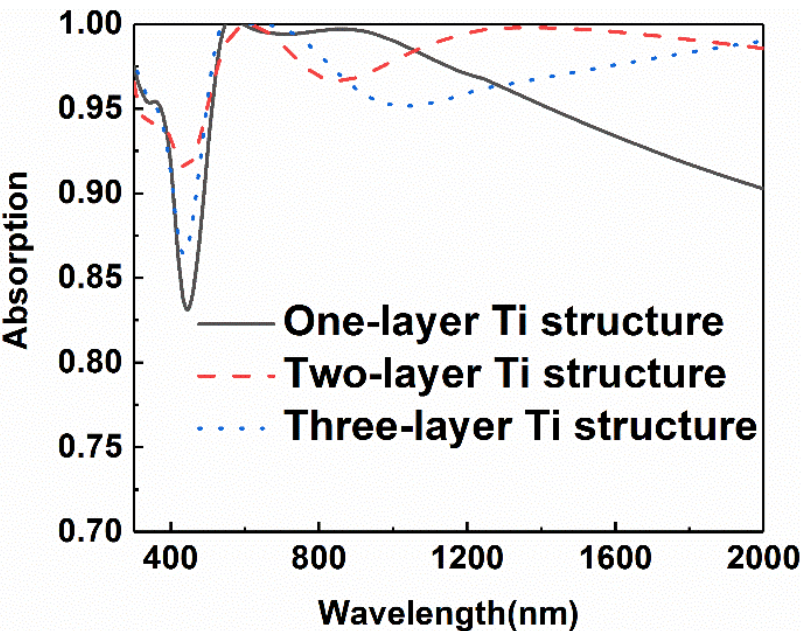
Figure 5. Comparison of absorption curves of the composite absorber with different titanium layer numbers in the bottom multilayer.